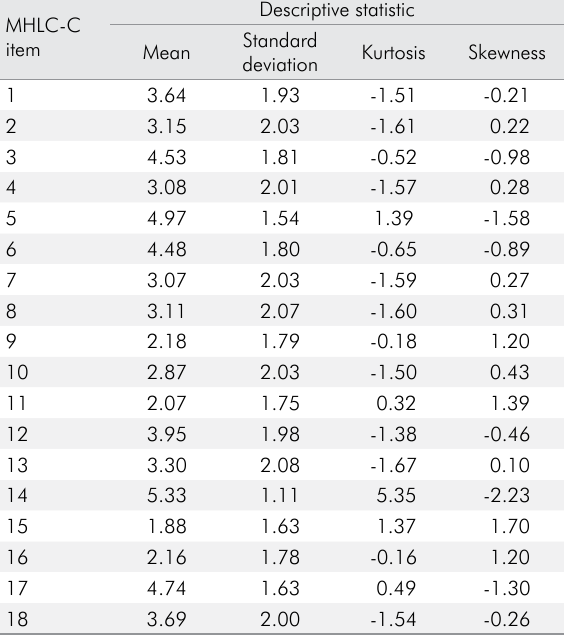
Table 4. Descriptive statistics (mean, standard deviation, kurtosis and skewness) of the participants’ responses to the Multidimensional Health Locus of Control - Form C (MHLC-C)